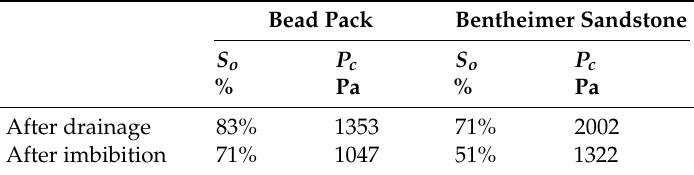
Table 2. Summary of the simulation results after the drainage and imbibition simulations. These values were obtained only for the pore structure